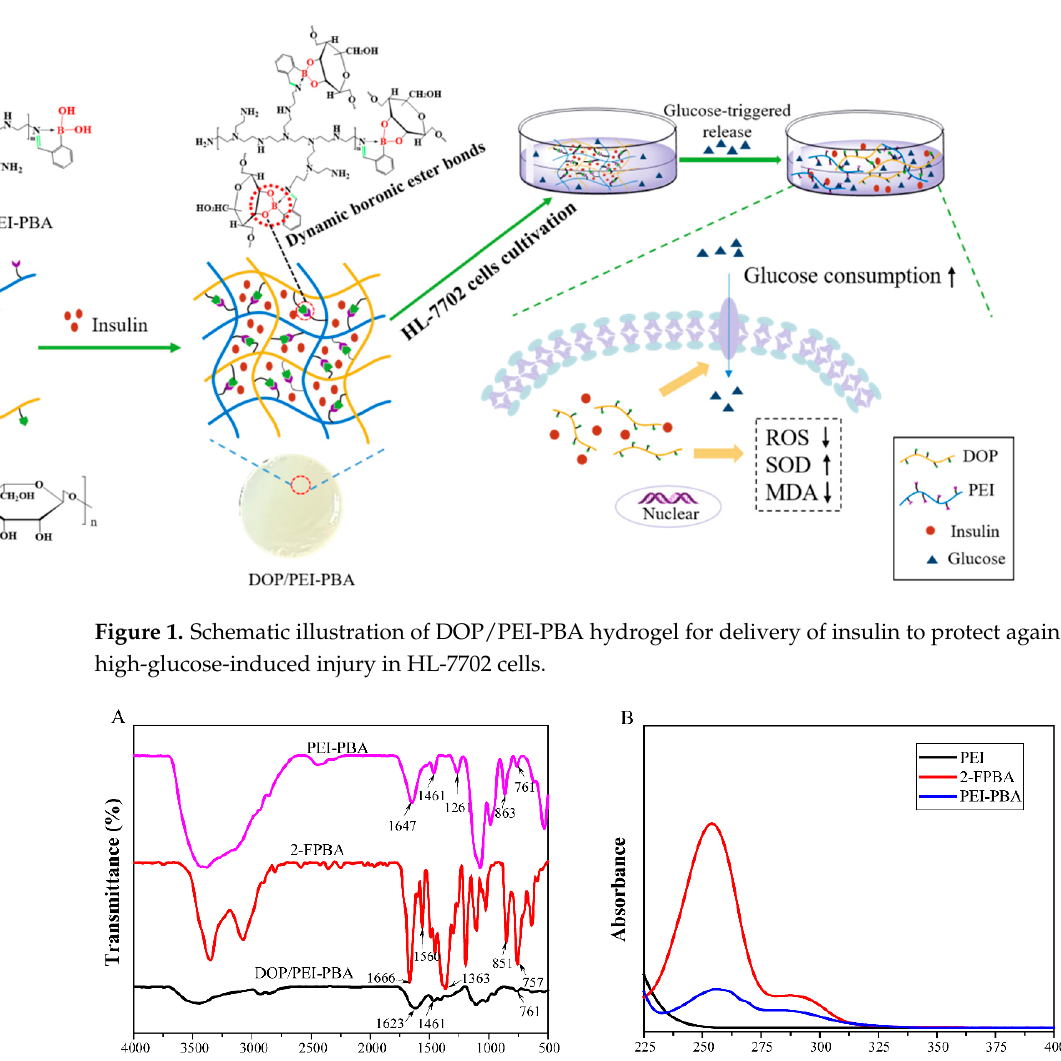
Figure 2. FT-IR spectra of 2 − FPBA, PEI-PBA and DOP/PEI − PBA hydrogel ( A ) and UV–vis spectra of PEI, 2 − FPBA and PEI − PBA ( B ).